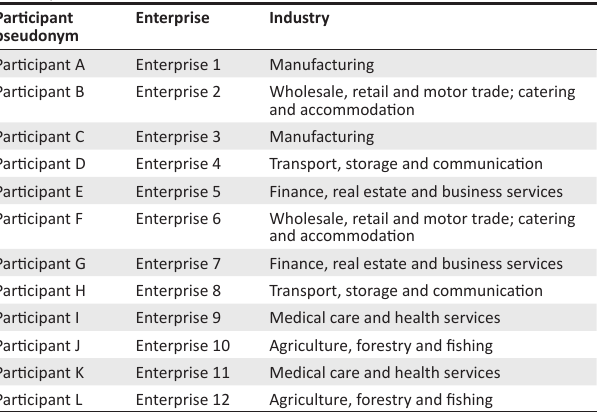
TABLE 1: Participant pseudonyms with their corresponding enterprise and industry. Participant